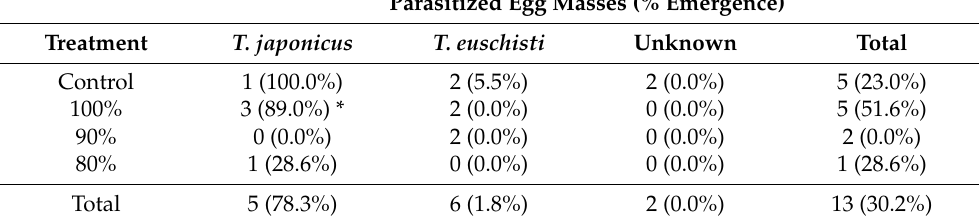
Table 1. Number of Halyomorpha halys egg masses parasitized (and percent of eggs with wasp emer- gence) in kairomone lure treatments for observed parasitoid species. Lure treatments are labeled based on percentage of n-tridecane a tt ractant to (E)-2-decenal repellent; the control contained only hexane. Ninety-two H. halys egg masses were deployed containing 2472 eggs on Catalpa speciosa leaves in Salt Lake City, UT, USA, from 24 June through 27 August 2021.